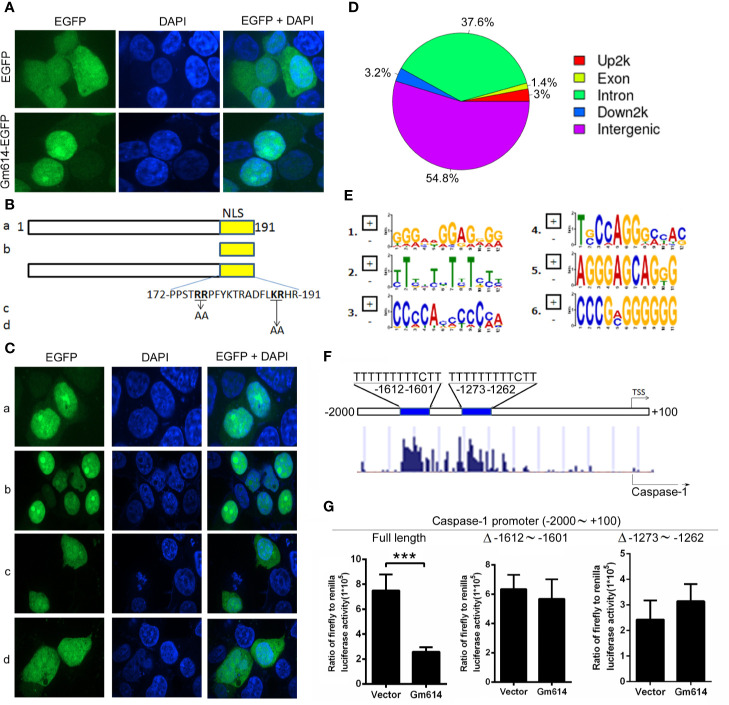
Gm614 suppressed caspase-1 transcription. (A) Gm614 was expressed in the nucleus. CD19+B220+CD38loGL7hi GC B cells were infected with lentiviruses with EGFP- or Gm614-EGFP-expressing LV122 and cultured for 2 days. Cells were imaged and analyzed on a GE IN Cell Analyzer 2000. Representative images show the nuclear location of Gm614. (B, C) Nuclear localization sequence (NLS) was located in C-terminal (172∼191) of Gm614. LV122 lentiviruses expressing (A) full length (1–191)-EGFP, (b) NLS (172–191)-EGFP, (c) full length with AA (176–177) mutation-EGFP, or (d) full length with AA (188–189) mutation-EGFP (B) were infected into CD19+B220+CD38loGL7hi GC B cells and on day 2, cells were imaged on a GE IN Cell Analyzer 2000 (C). (D–F) Gm614 bound with the caspase-1 promoter. CD19+B220+CD38loGL7hi GC B cells were infected with lentiviruses containing EGFP- or Gm614-EGFP-expressing LV122, and cultured for 3 days. Genome-wide mapping of Gm614 binding in GC B cells by ChIP-seq. (D) Distribution of Gm614-binding peaks. (E) De novo motif prediction by DNA sequences enriched in Gm614 binding regions. (F) Genomic snapshots depicting the ChIP-seq results for Gm614 (lower panel) and the predicted motif (upper panel) at the promoter regions of the caspase-1 genomic loci. (G) Gm614 suppressed the activation of caspase-1 promoter. Gm614-expressing LV201 (Gm614) or empty vector LV 201 (Vector) and luciferase reporter vector pEZX-PG04.1/caspase-1 promoter (-2000 ∼ +100 bp of mouse caspase-1 gene) (Full length), caspase-1 promoter with the deletion of -1612 ∼ -1601 (Δ -1612 ∼ -1601) or -1273 ∼ -1262 (Δ -1273 ∼ -1262) were co-transduced into 293T cells. Dual luciferase reporter gene expression was analyzed, and the results are shown as the ratio of firefly to Renilla luciferase activity. (A, C, G) Data represent three independent experiments, with six samples per group per experiment. (G) Student’s t-test (two tailed), Error bars, s.e.m., ***p < 0.001.